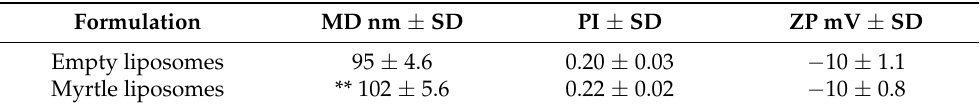
Table 2. Characteristics of empty and myrtle liposomes: mean diameter (MD), polydispersity index (PI), and zeta potential (ZP). Each value represents the mean ± SD ( n > 10). ** Values statistically different ( p < 0.01) from empty liposomes.